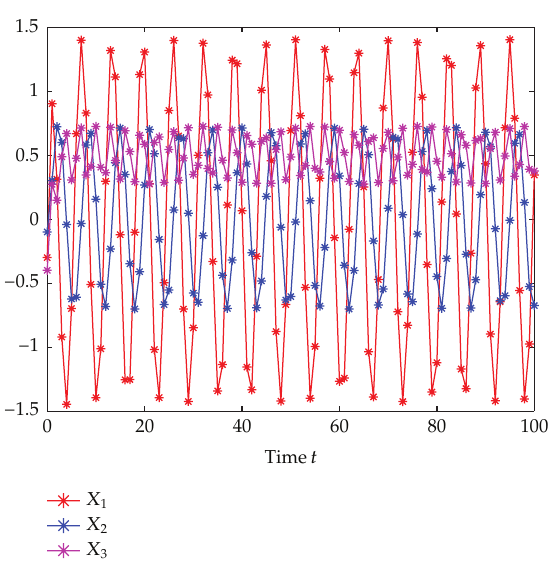
Figure 1: Transient response of state variables x 1 ,x 2 , and x 3 in Example 4.8.